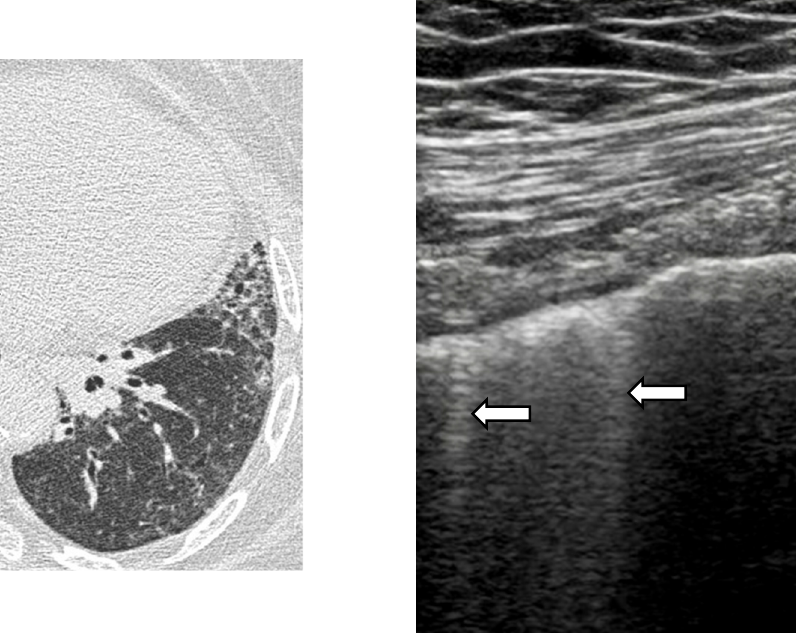
Figure 1. HRCT scan of a patient with systemic sclerosis. The axial scan ( A ) shows diffuse, bilateral, symmetrical ground- glass opacities in the lung parenchyma. The alterations have a basal predominance, as better appreciated on the coronal reconstruction ( B ). Note the dilated esophagus (arrow in A ), an important accessory finding in this disease.